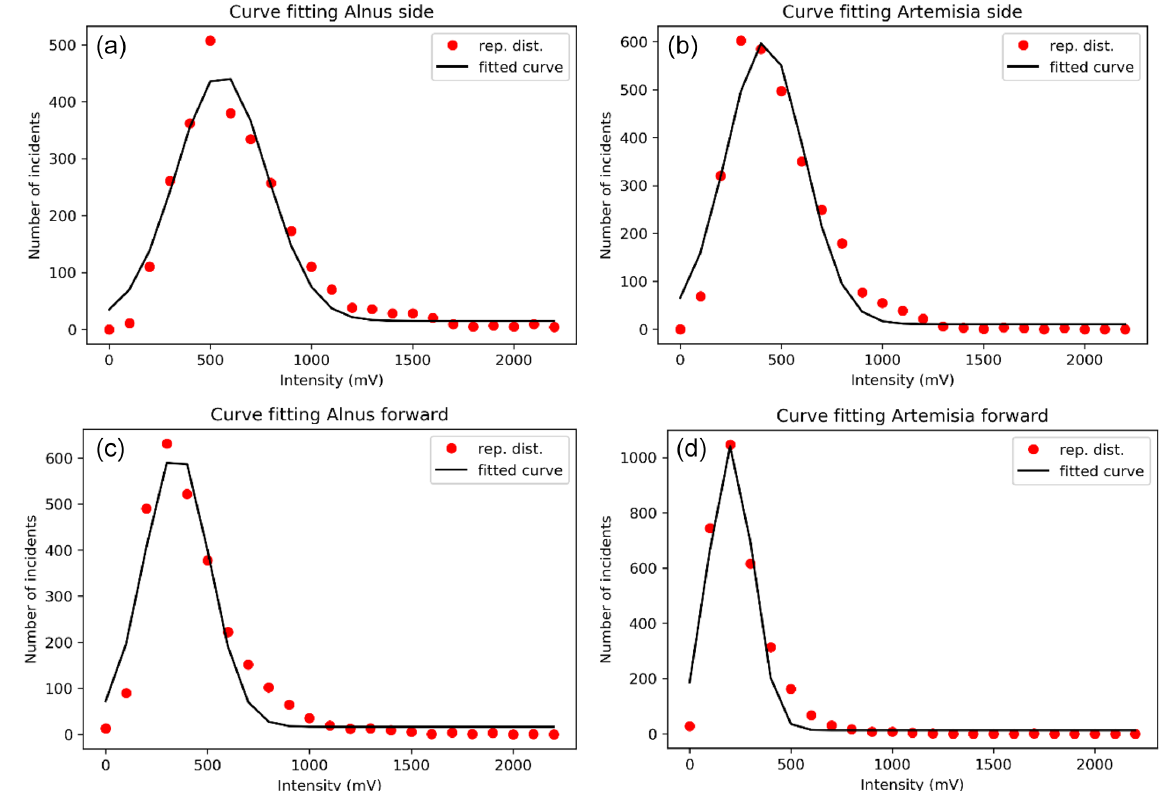
Figure 5. A fitted curve for side scattering for (a) Alnus and (b) Artemisia and a fitted curve for forward scattering for (c) Alnus and (d) Artemisia .